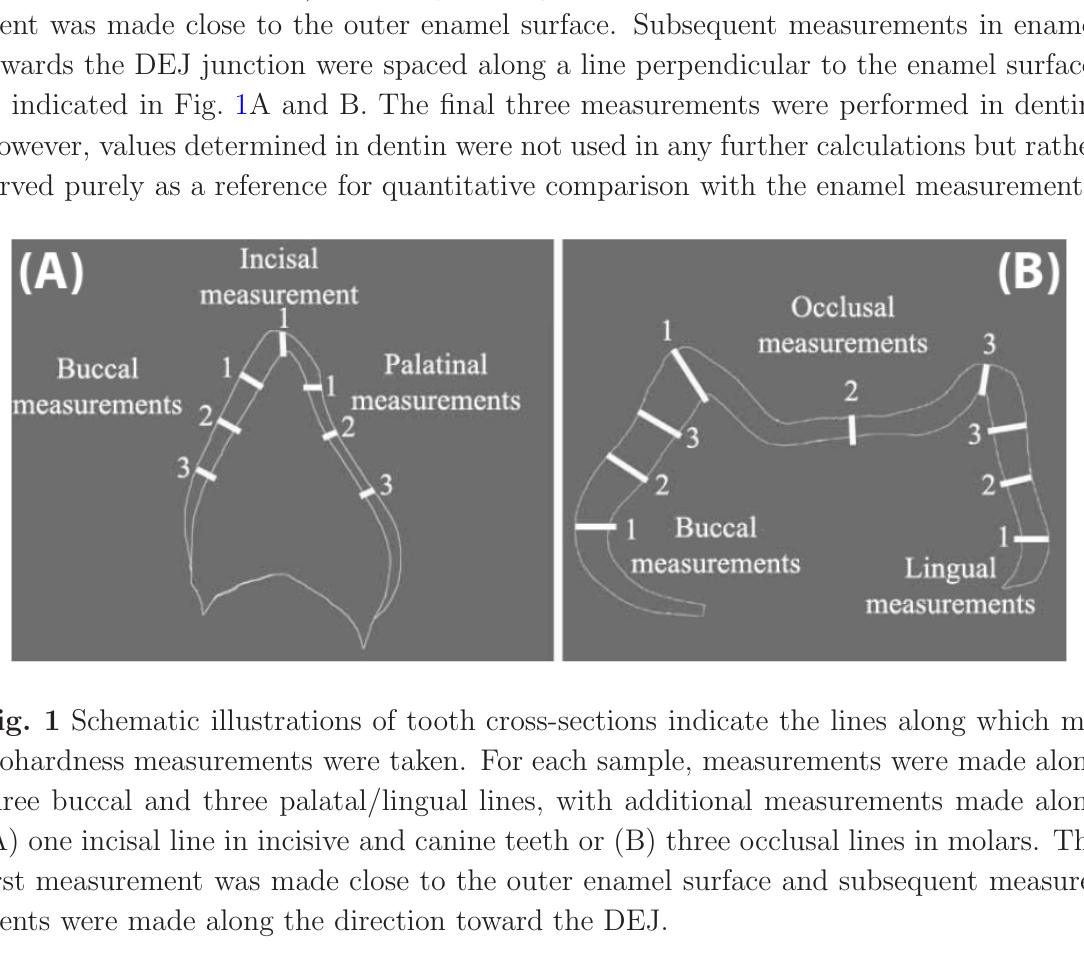
(A) one incisal line in incisive and canine teeth or (B) three occlusal lines in molars.